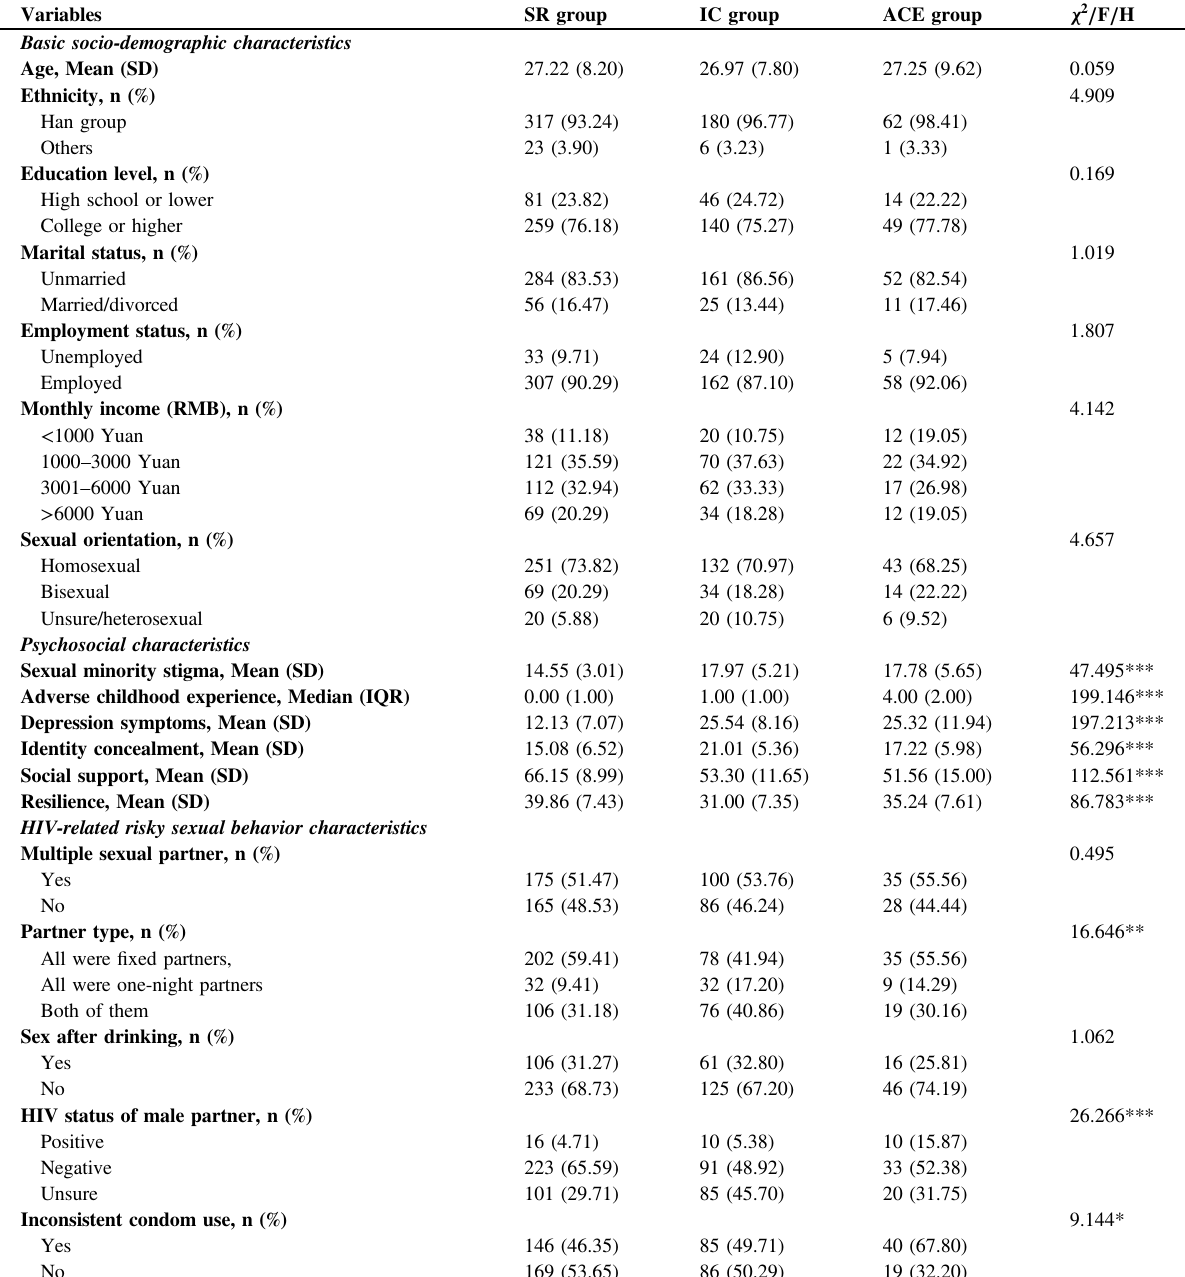
Table 3 Basic socio-demographic, psychosocial and HIV-related risky sexual behavior characteristics of three groups. (N = 589). Variables SR